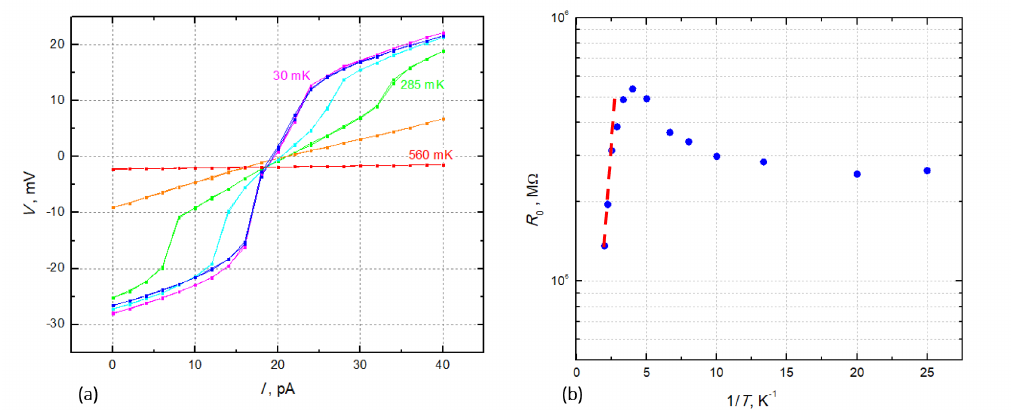
Figure 3. ( a ) Current-voltage characteristics of two connected in series SQUIDs measured at Φ = 0.5 Φ 0 and different temperatures (from 30 mK to 560 mK, as shown in the panel). The SQUIDs are formed by JJs with E J = 0.76K (sample 3 in Table 1). ( b ) The temperature dependence of the zero- bias resistance for this sample. The red dashed line corresponds to the dependence R 0 ( Φ = 0.5 Φ 0 , T ) = 4 k Ω × exp ( δ / T ) with δ = 2.1